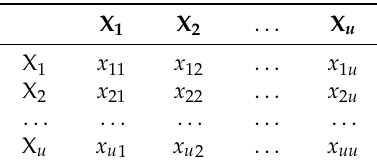
Table 1. Comparison matrix elements.